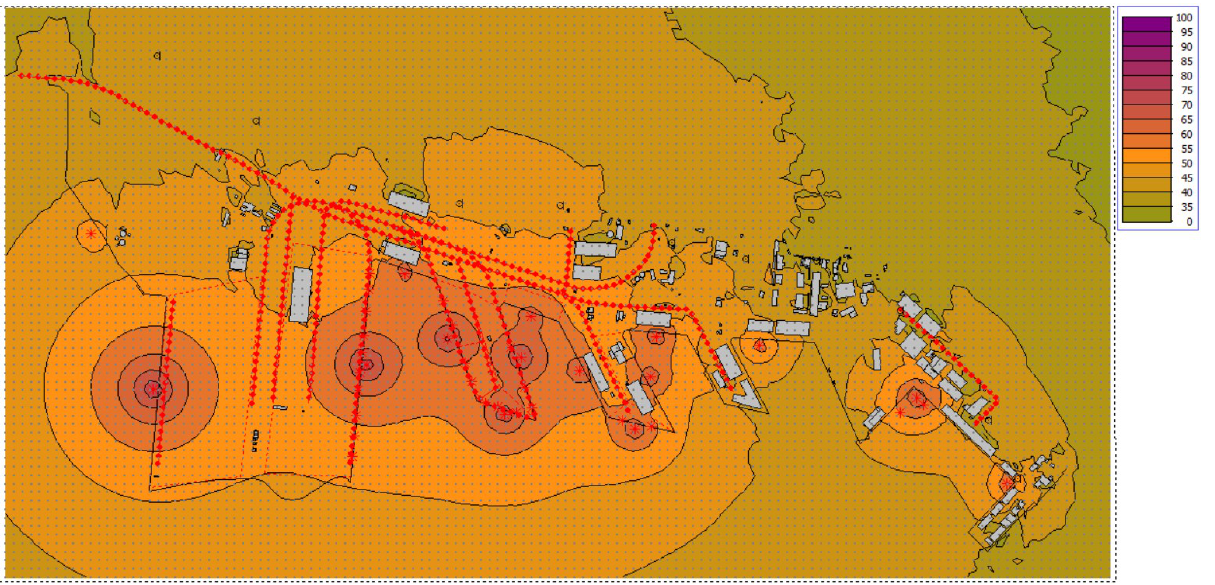
Figure 6: Noise map of the Port of Thessaloniki for the scenario without wind influence (Lnight)